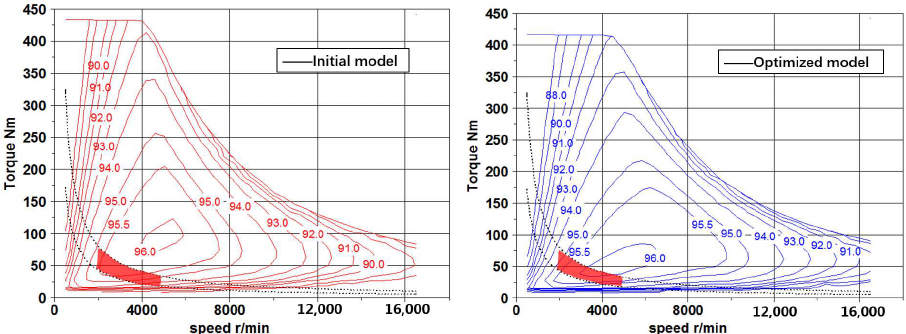
Figure 15. Comparison of efficiency map.